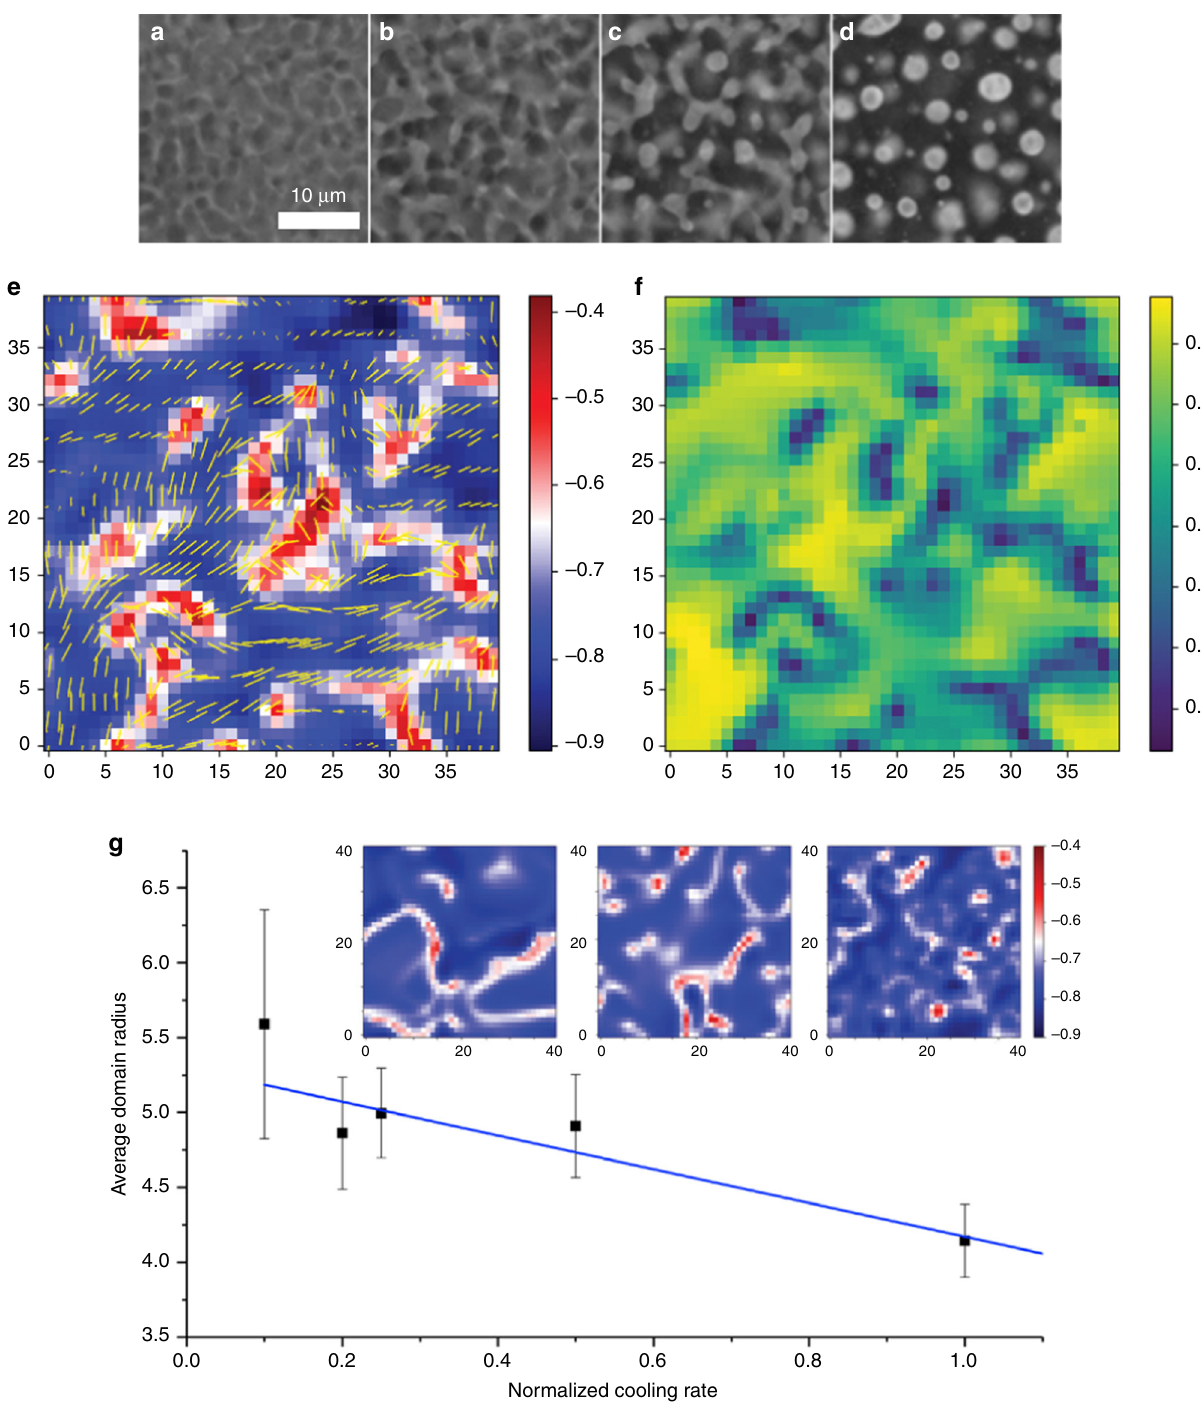
Fig. 4 Computer simulations of initial stage structure development. a – d Experimental high-speed video imaging snapshots representative of four stages in nematic nucleation and growth during the process: a initial nucleation and growth, b coarsening, c domain separation, and d secondary nucleation. e Two- dimensional (2D) cross-sections of three-dimensional (3D) simulation results for the early stages of nucleation and coarsening showing nanoparticle-rich (redder) and nanoparticle-poor regions (bluer). The images are colored with a linear scale in arbitrary units and overlaid with yellow arrows indicating local director orientation. The concentration distribution is compared with f , the calculated order parameter map for the same area using a linear scale from 0 to 1. The comparison clearly indicates a correlation between lower ordered regions and higher particle concentrations. g Average particle-rich domain size as a function of cooling rate calculated from simulation results. Error bars represent the standard error of the mean (s.e.m.) measured over fi ve samples. Three simulation snapshots (inset) comparing cooling rates of 0.2, 0.5, and 1.0, from left to